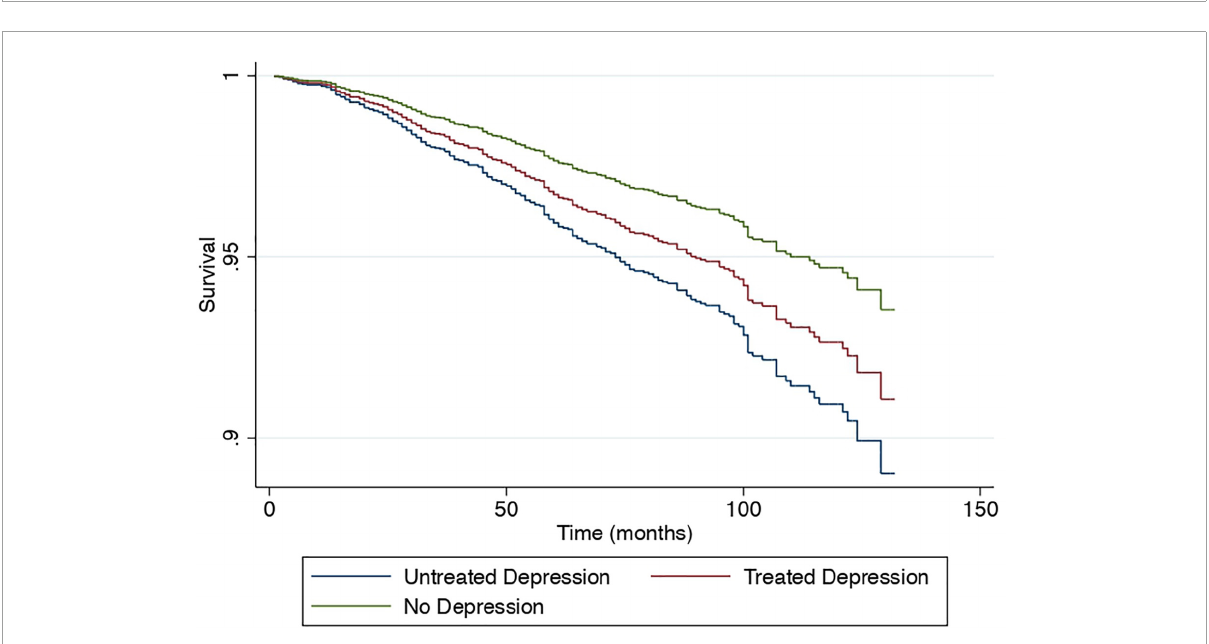
FIGURE5 Cox proportional survival of all-cause mortality without depression, treated and untreated